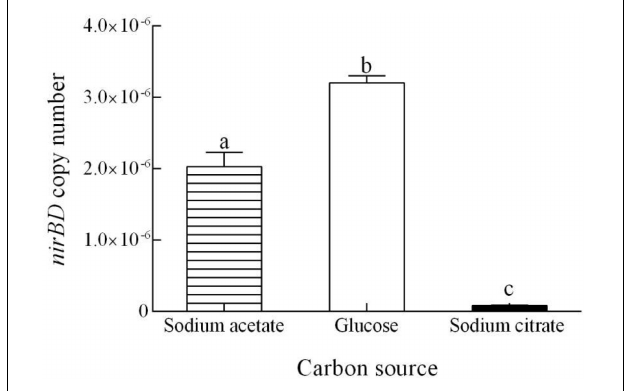
FIGURE 2 | Quantitative measurement of the nirBD expression in Pseudomonas putida Y-9 cultured with different carbon sources for 4 d. The values are expressed as the number of copies/10 10 copies of 16S rRNA. The different lowercase letters above the bars indicate significant differences among treatments ( P <